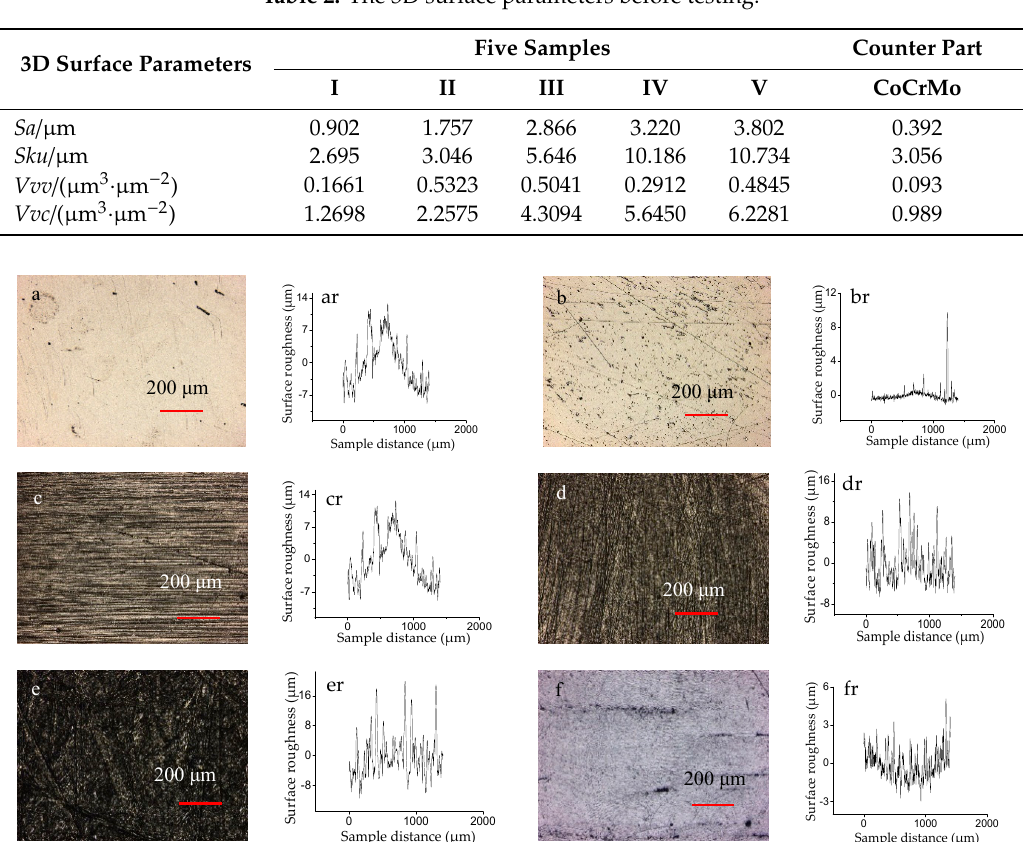
Figure 2. The 3D profiles and 2D roughness curves of the surface of the samples: (( a ) and (ar)) for I, (( b ) and (br)) for II, (( c ) and (cr)) for III, (( d ) and (dr)) for IV, (( e ) and (er)) for V, and (( f ) and (fr)) for counterpart.